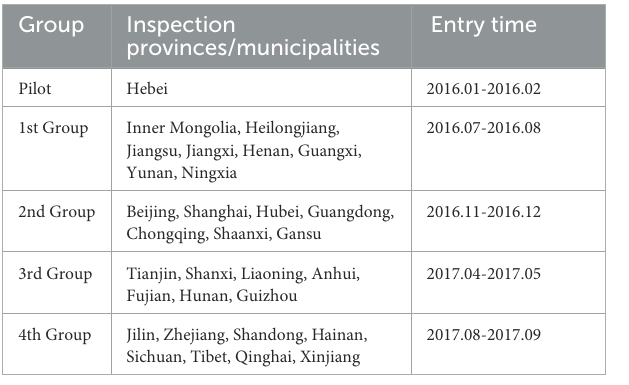
TABLE 1 Dates of implementation of the first round of CEPI. Group